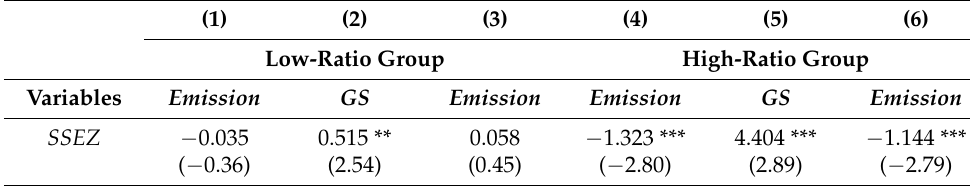
Table 7. Heterogeneity analysis by industry structure